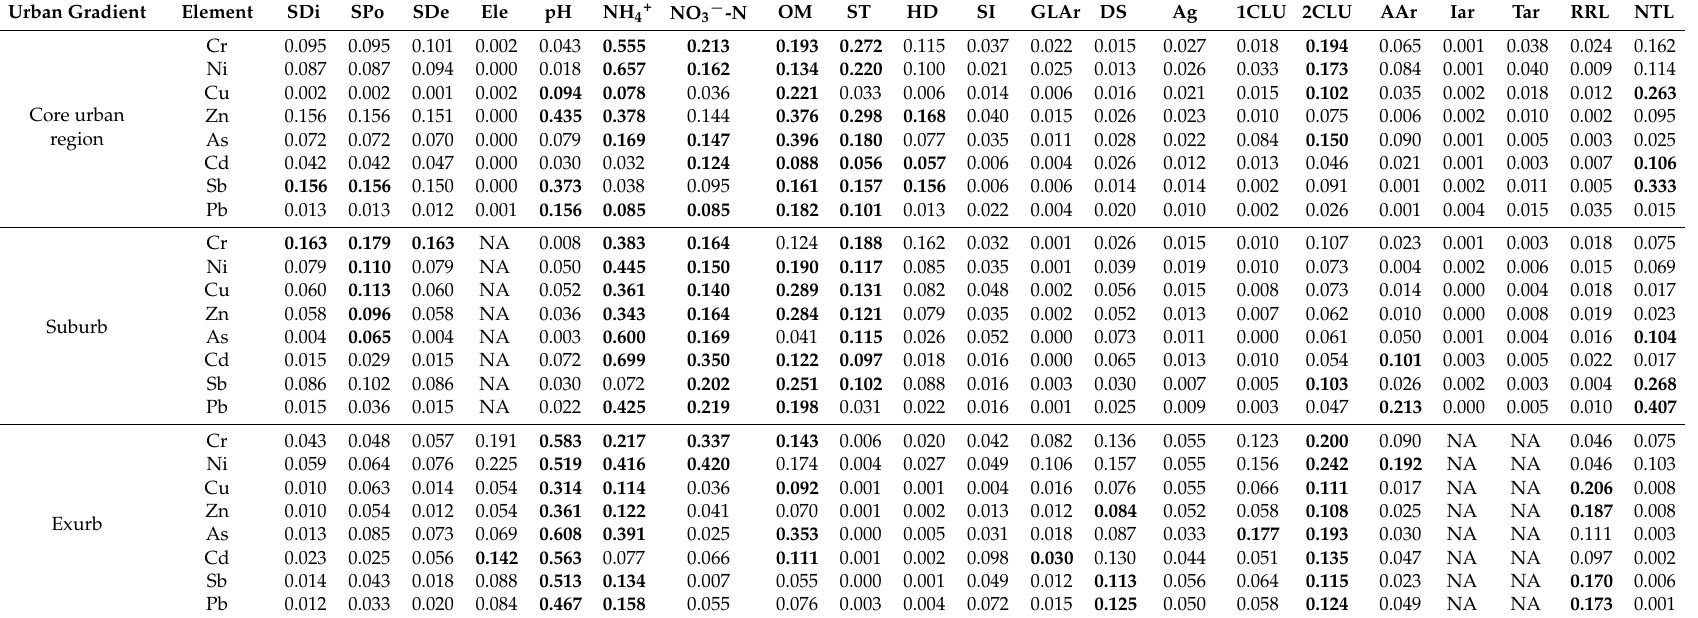
Table 5. The contributions of 17 factors to the concentrations of eight heavy